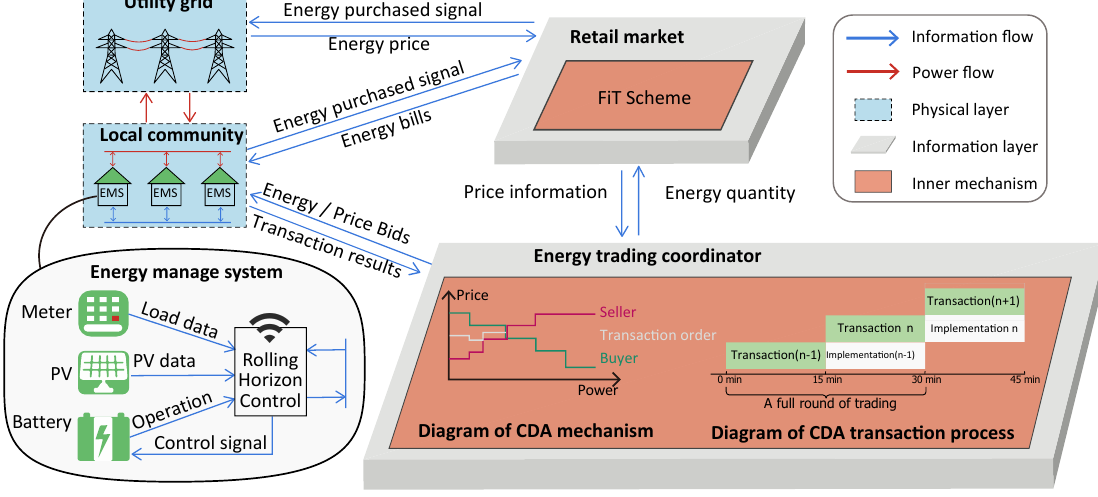
Figure 1. Framework of local P2P trading using continuous double